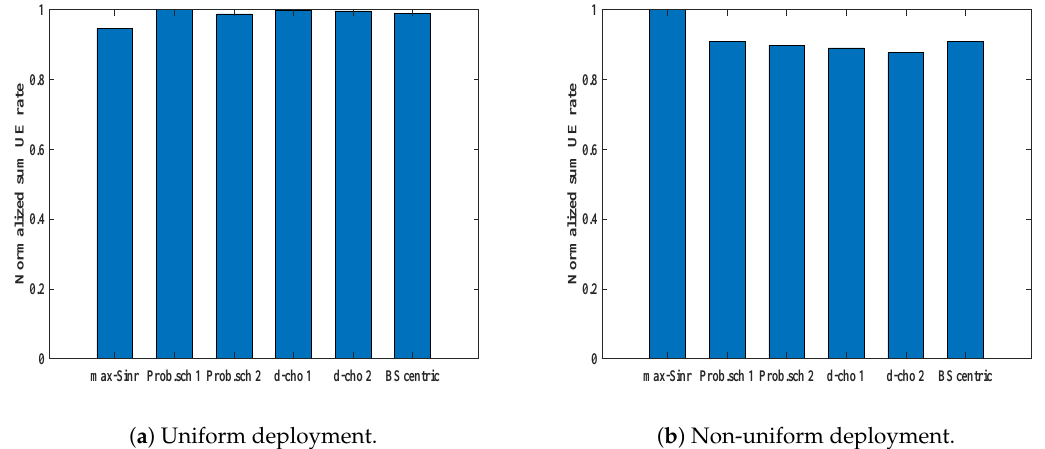
( a ) Uniform deployment. ( b ) Non-uniform deployment. Figure 9. Normalized sum rate for different association schemes in different deployment